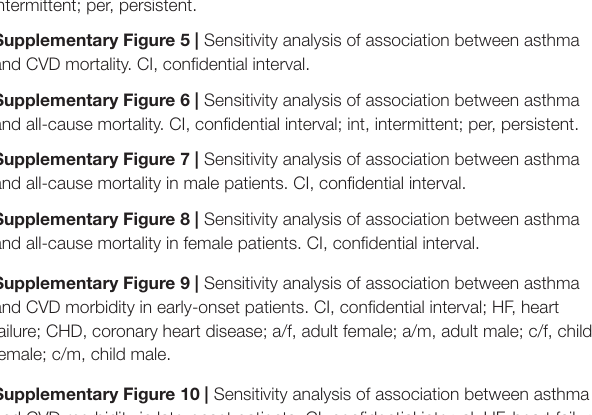
Supplementary Figure 1 | Funnel plot depicting publication bias for the association between asthma and CVD morbidity. SE, standard error; RR, relative risk. Supplementary Figure 2 | Funnel plot depicting publication bias for the association between asthma and CVD mortality. SE, standard error; RR, relative risk. Supplementary Figure 3 | Funnel plot depicting publication bias for the association between asthma and all-cause mortality. SE, standard error; RR, relative risk.